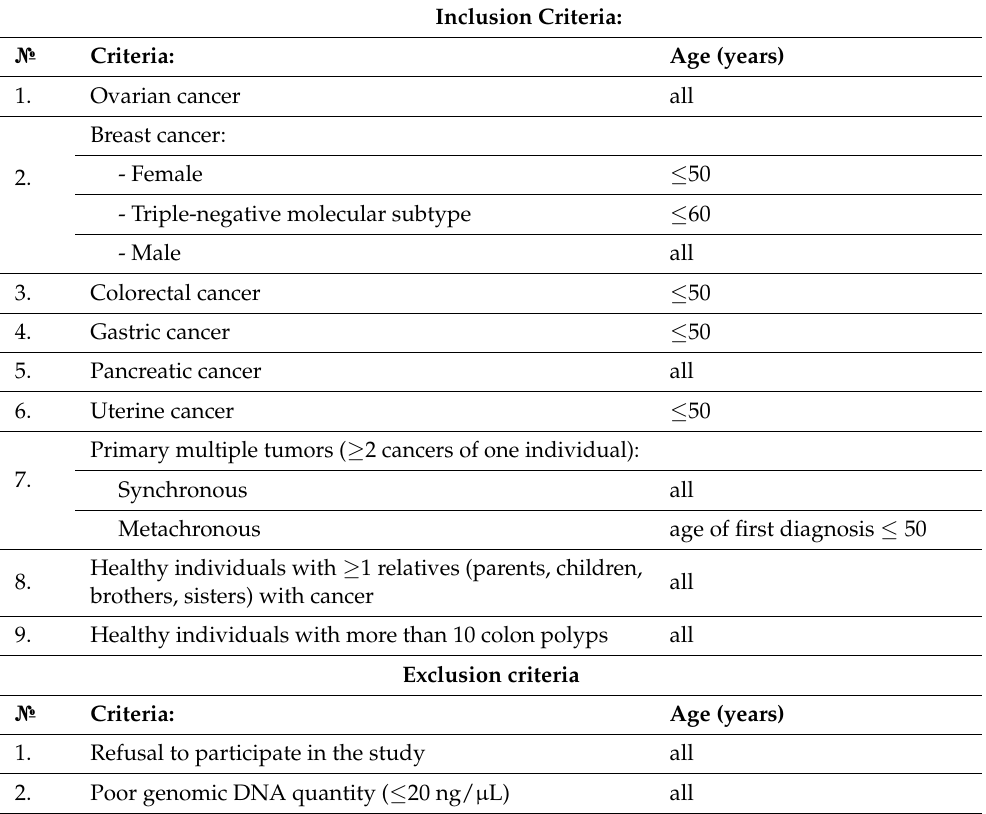
Table 1. Selection criteria for molecular genetic